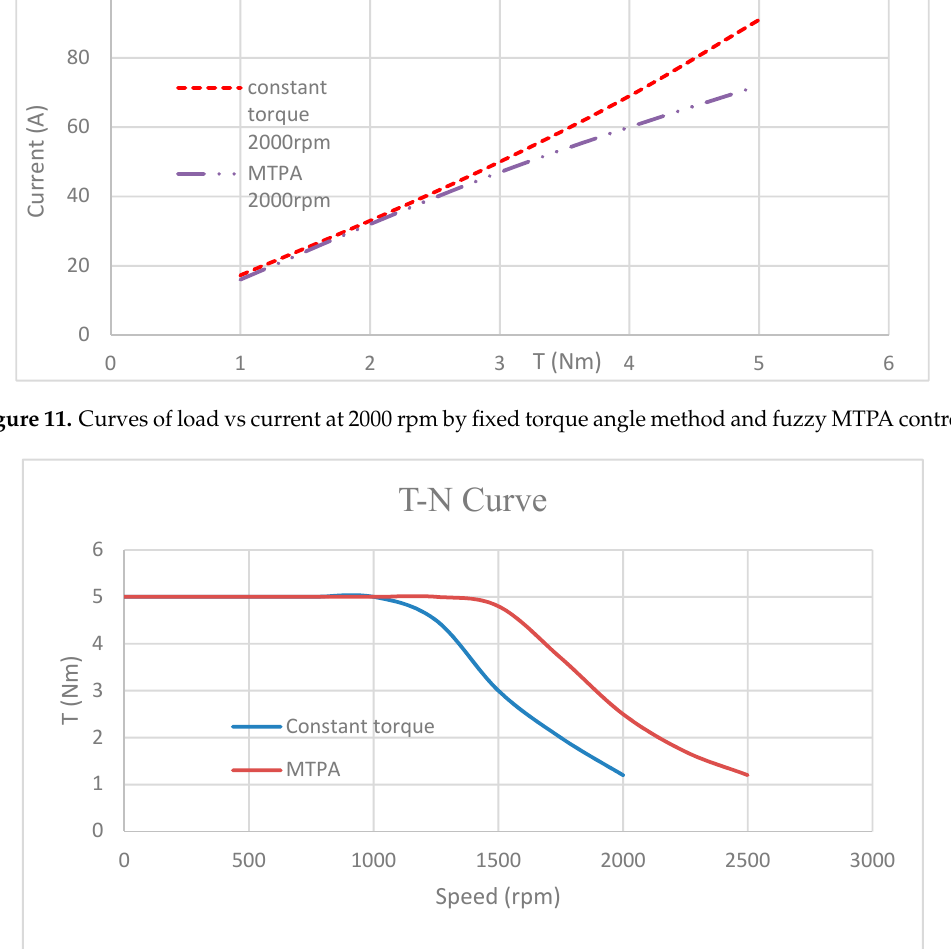
Figure 8. Curves of load vs current at 300 rpm by fixed torque angle method and fuzzy MTPA control. Electronics 2018 , 7 , x FOR PEER REVIEW